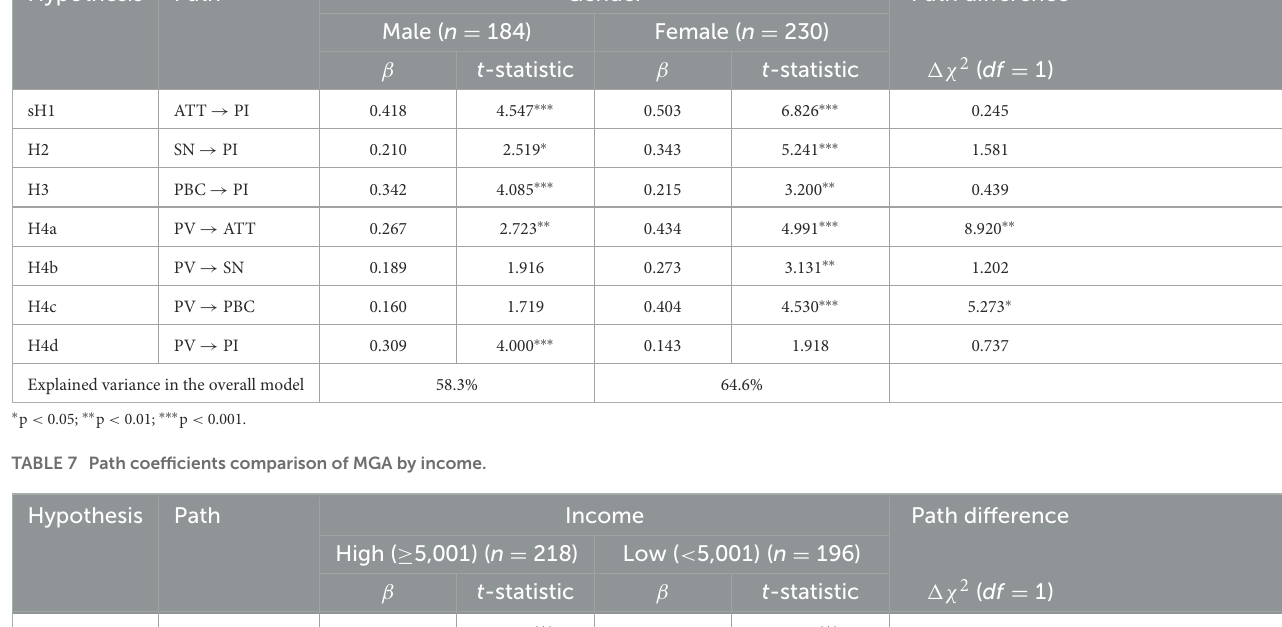
TABLE 6 Path coefficients comparison of MGA by gender. Hypothesis